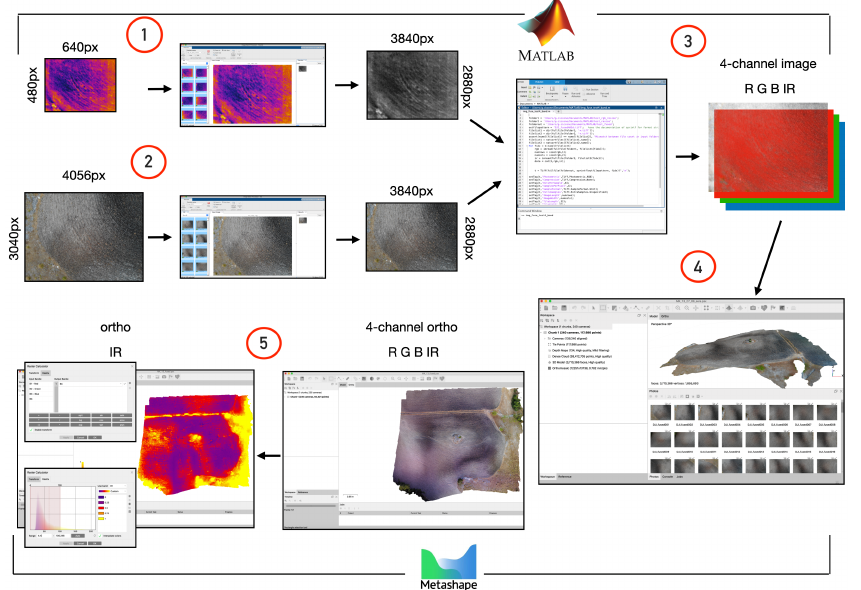
Figure 14. Graphic representation of the workflow developed for the processing of aerial thermal images with proprietary software: (1) Convert and resize the thermal images; (2) Crop the RGB images; (3) Merge thermal and RGB images; (4) Photogrammetric phase; (5) Extract thermal orthophoto in Metashape.